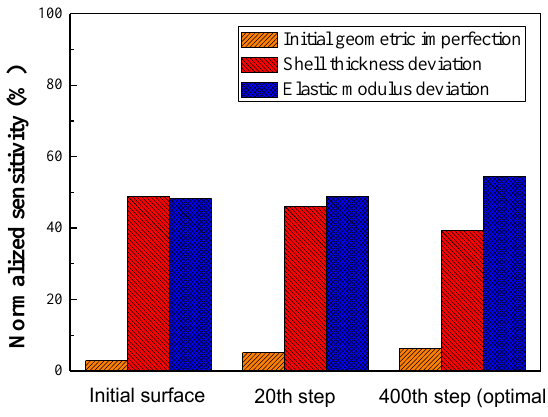
Figure 10. Normalized sensitivity of uncertainty factors of Model 1.